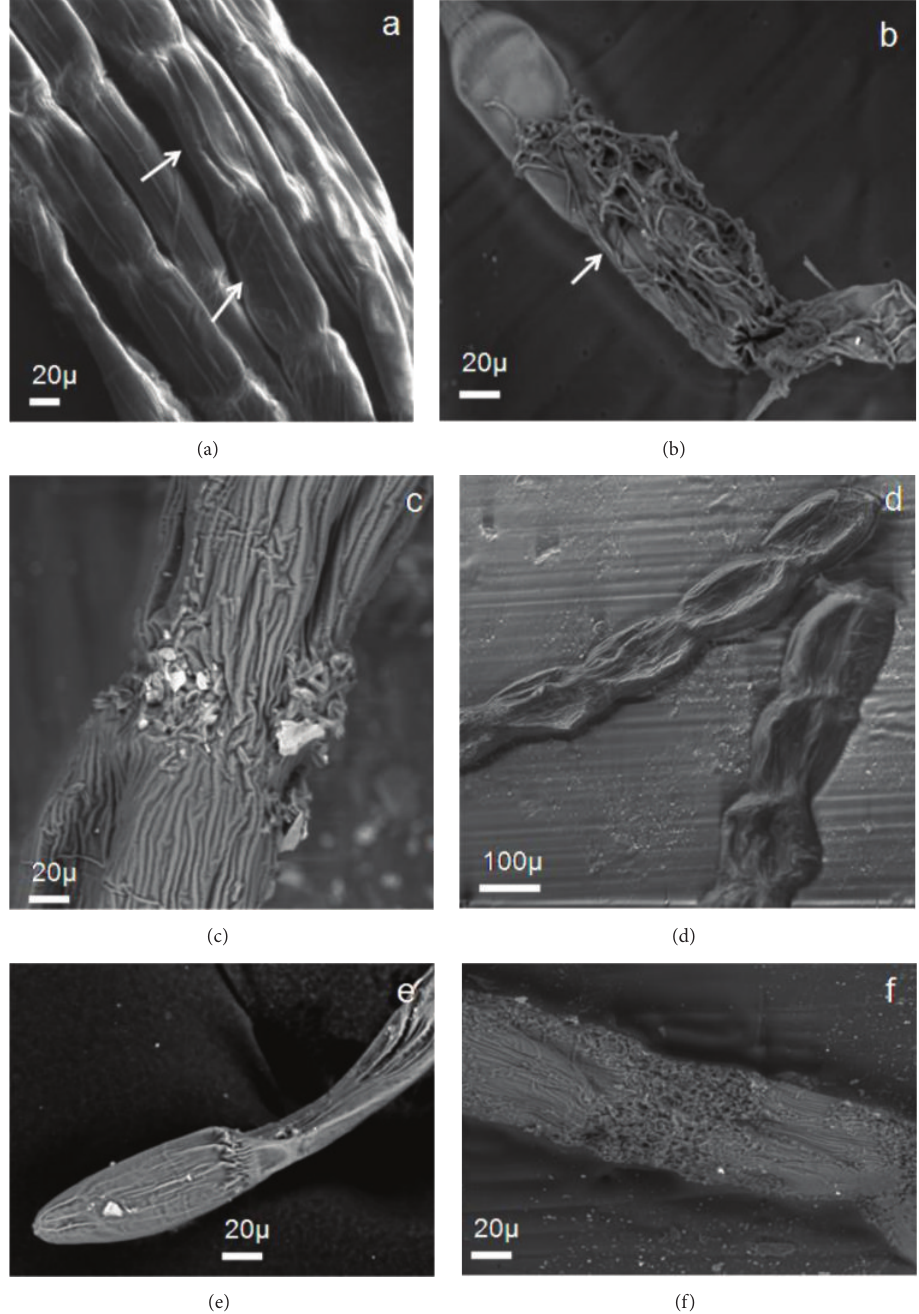
Figure 1: Showing SEM micrographs of R. africanum under nitrate and phosphate stress. (a) Untreated intact cell ( × 1.0KX). (b) Disintegrated cell wall polysaccharides of AN treated cell ( × 1.0KX). (c) Cell with degraded cellulose macrofibrils in AP condition ( × 1.0KX). (d) Cells become swollen and rectangular to oval in DDP media ( × 256X). (e) A terminal cell with folded margins in DDP treated condition ( × 1.0KX). (f) Cross wall with greater folding of cellulosic macrofibrils in DDN treated cell ( × 500